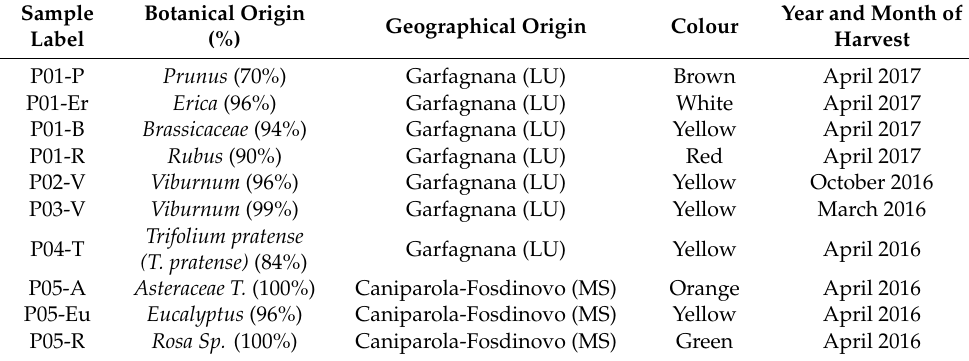
Table 1. List of the bee pollen samples investigated in this work. The sample label reflects the sample of origin (P0X) followed by one of two letters to indicate their botanical origin. The botanical origin is expressed in %, the geographical origin, the color, and year and month of harvesting are also reported. Each pollen load owned a homogeneous and monospecific pollen